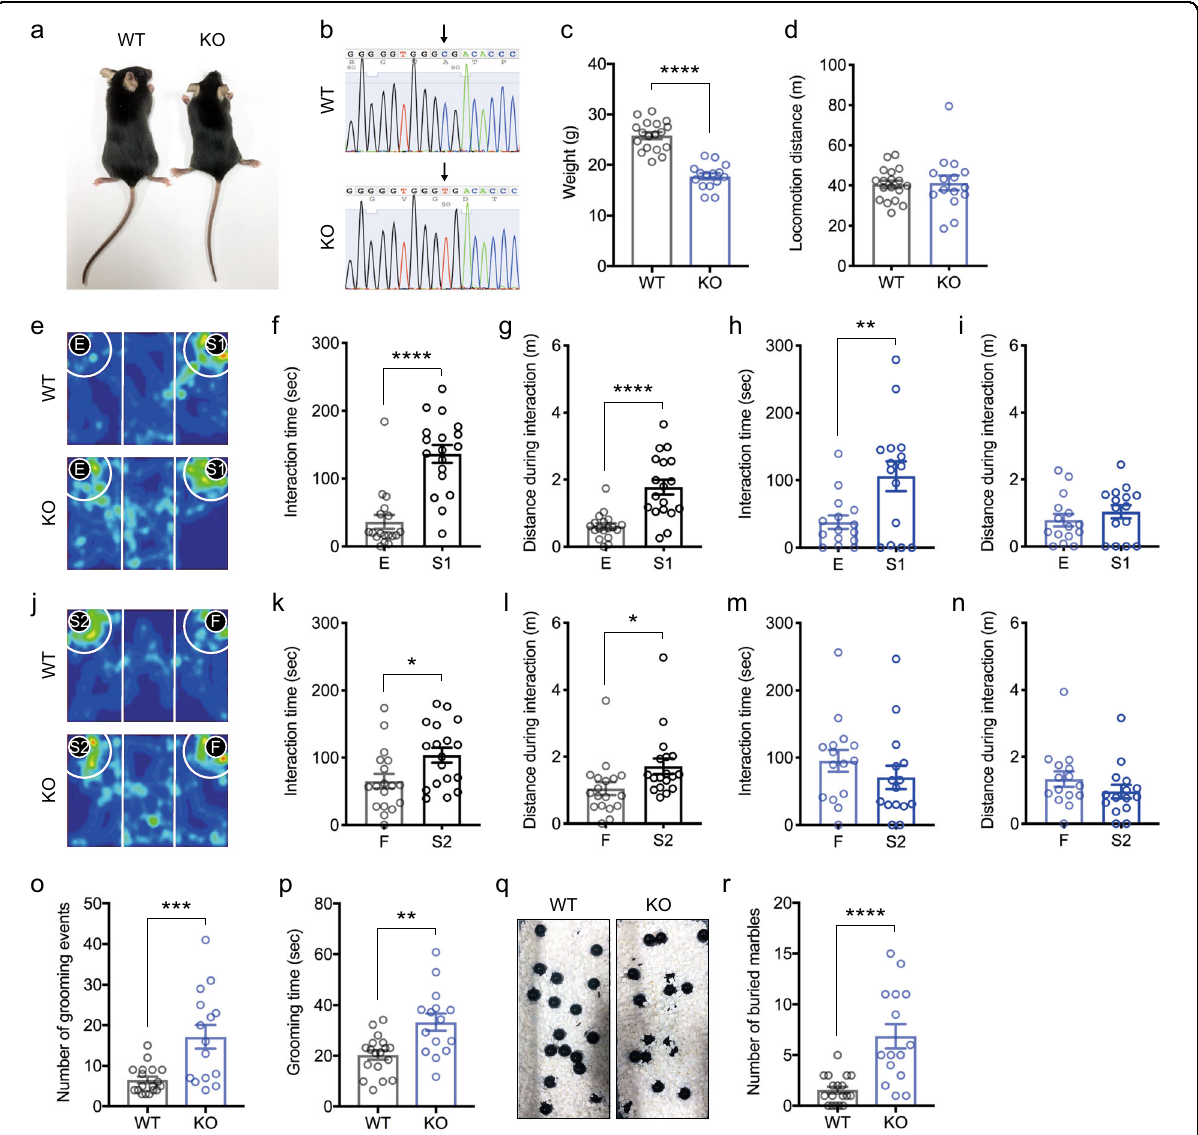
Fig. 1 Zbtb16 KO mice display social impairment and repetitive behaviors. a Zbtb16 KO mice display small bodies and hind limb dysplasia.